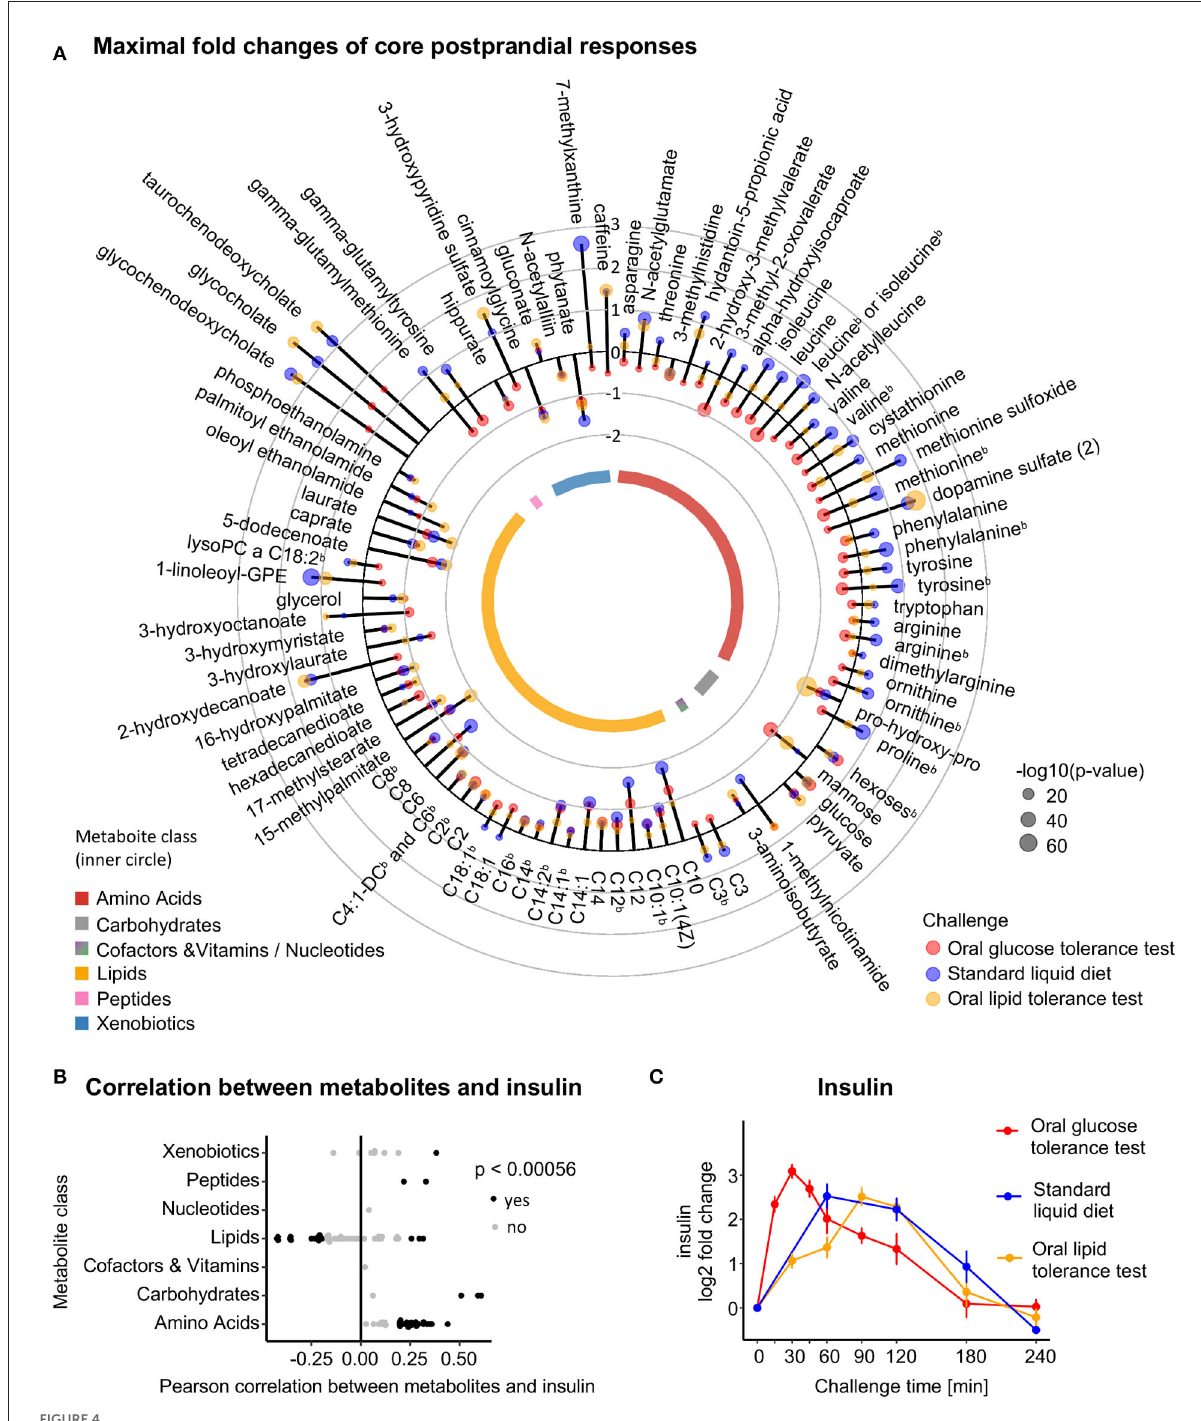
FIGURE4 Metabolite pool of the core postprandial response to dietary intake. (A) Circular plot of the largest absolute log 2 fold changes of the 89 metabolites that display significant concentration changes in all three challenges. Lollipop length represents the largest log 2 fold change in a metabolite within each challenge; colors represent the challenge and the size of the bubble represents the –log10( p -value); the gray circles indicate log 2 fold changes from − 2 to 3; b indicates metabolites measured using targeted metabolomics (Absolute IDQ p150). (B) Pearson correlation of the 89 core metabolites with insulin sorted by metabolite class and colored by significance after multiple testing (black: Bonferroni adjusted p < 0.05). (C) Time-resolved log 2 fold changes of insulin levels in relation to the time of ingestion ( t = 0) for the three challenges (red: OGTT; blue: SLD challenge; yellow: OLTT). Data are represented as mean over the 15 participants ±